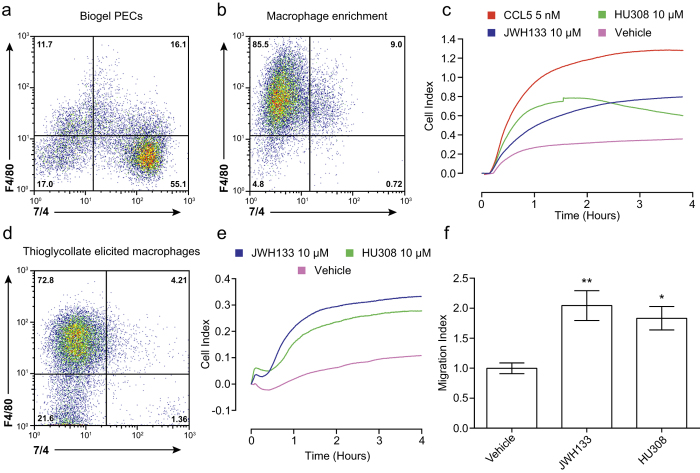
Macrophages are the dominant cell population in bio-gel elicited PECs that migrate toward CB2 agonists. (A) Flow cytometry analysis demonstrates that neutrophils (F4/80-, 7/4+) are the major cell population within bio-gel elicited PECs, whereas macrophages (F4/80+, 7/4-) and monocytes (F4/80+, 7/4+) form only a minor population. (B) Bio-gel elicited PECs were placed into petri dishes and allowed to adhere for 2 hours at 37 °C, 5% CO2 prior to washing with PBS. Cells were then left overnight at 37 °C, 5% CO2 and remaining adherent cells removed using PBS containing 10 mM EDTA. Flow cytometry analysis of these cells after staining with F4/80 and 7/4 demonstrates that this process strongly enriches macrophages and removes neutrophils. (C) Enriched macrophages (2 × 105) were placed into the upper chamber of a CIM-16 plate and allowed to migrate for 4 hours at 37 °C, 5% CO2 toward vehicle (0.3% DMSO), 5 nM chemokine or 10 μM cannabinoid. Real-time chemotaxis analysis demonstrates that JWH133 and HU308 caused strong directed migration of this macrophage population. Data show mean trace of 3-4 technical replicates per condition. (D) Flow cytometry analysis using F4/80 and 7/4 demonstrates that macrophages are the main cell population elicited by intraperitoneal injection of 4% thioglycollate. (E,F) Thioglycollate elicited macrophages (2 × 105) were placed into the upper chamber of a CIM-16 plate and allowed to migrate for 4 hours at 37 °C, 5% CO2 toward vehicle (0.3% DMSO) or 10 μM cannabinoid. (E) Representative real-time chemotaxis trace of thioglycollate elicited macrophage migration towards JWH133, HU308 or vehicle. Data show mean trace of 3-4 technical replicates per condition. (F) Quantification of chemotaxis demonstrates that JWH133 and HU308 significantly induced thioglycollate elicited macrophage chemotaxis. Data are mean ± SEM, n = 4-6 biological replicates with 3-4 technical replicates per condition. Statistical analysis was conducted by one-way ANOVA with Dunnett’s multiple comparisons correction. * P < 0.05, ** P < 0.01, comparing all samples to vehicle control.